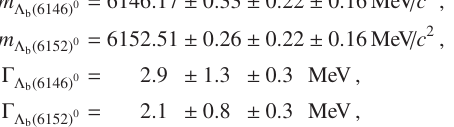
Figure 4. Mass distribution of selected Λ 0 Λ 0 J / ψ pK − decay modes. Mass distributions of selected Λ 0 b → Λ 0 π ± mass (right): (top) Σ ± b Λ b (6152) 0 contributions in each region are